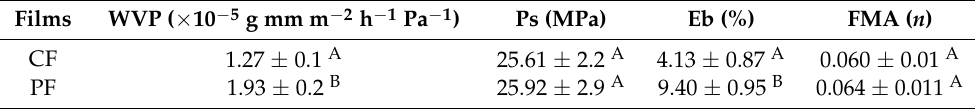
Results presented as mean ± SD. ( n = 3). Means in the same column followed by different capital letters (A or B) are significantly different by t -test ( p = 0.03). WVP: Water vapor permeability; Ps: Puncture strength; Eb: Elongation at break; FMA: Mucoadhesive Force.